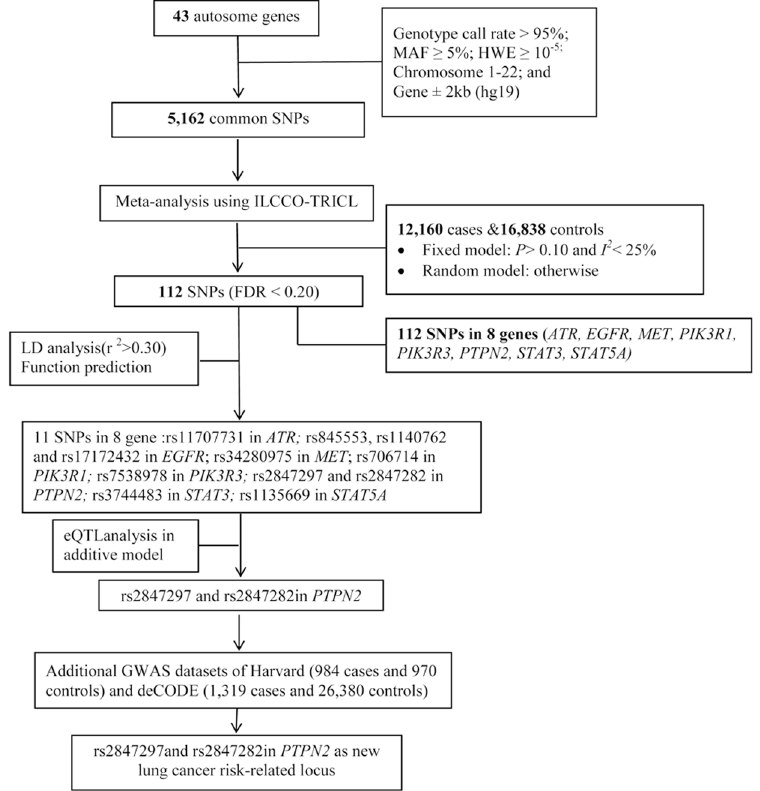
Figure 4. Flowchart of SNP selection among the TCPTP pathway